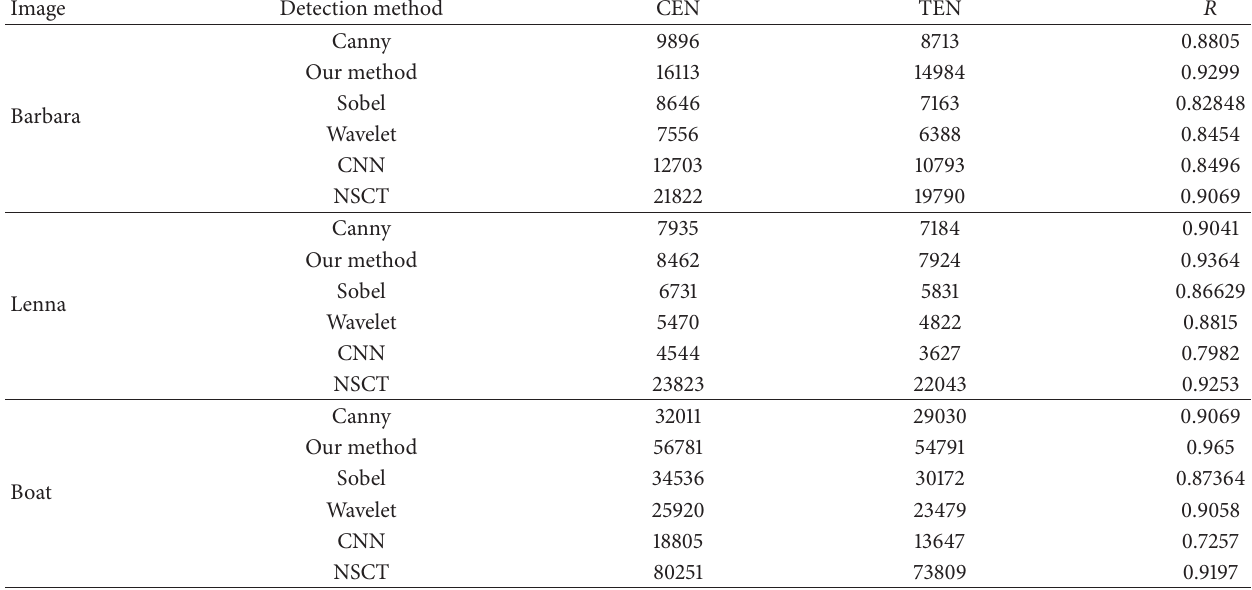
Table 2: The comparison of the different detection methods.